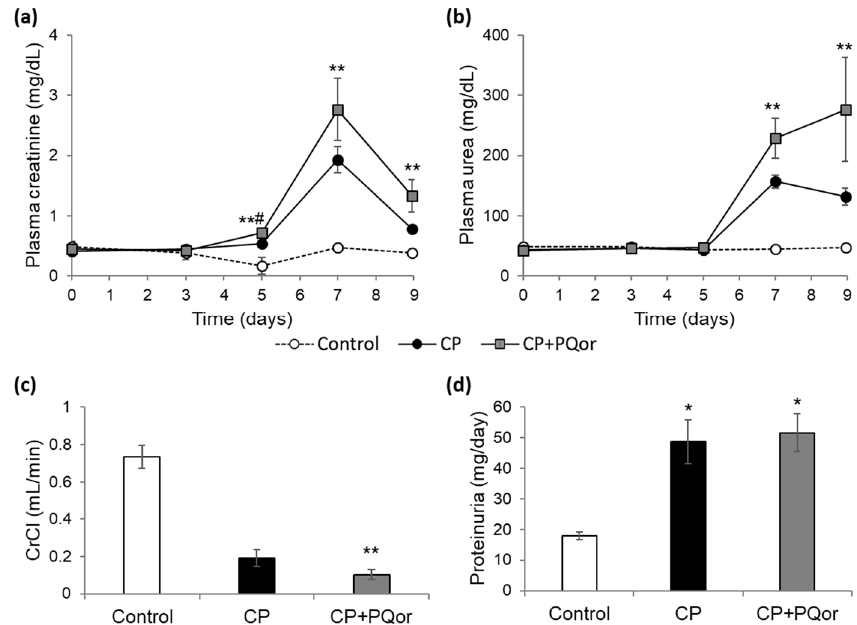
Figure 1. Evaluation of renal function in rats. ( a ) Evolution of plasma creatinine; ( b ) evolution